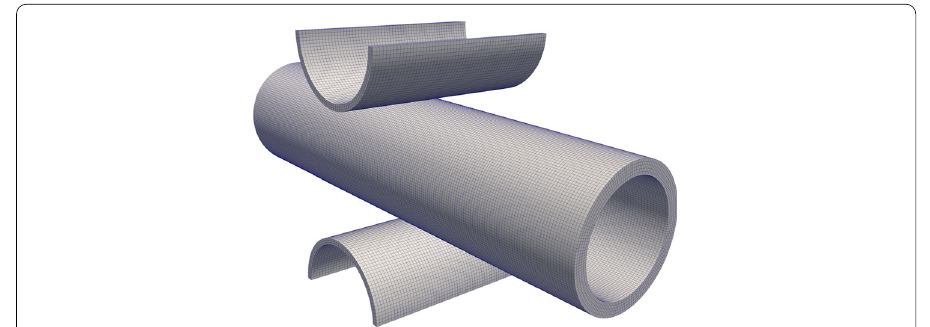
Fig. 9 Squeezed elasto-plastic tube—initial configuration and employed mesh